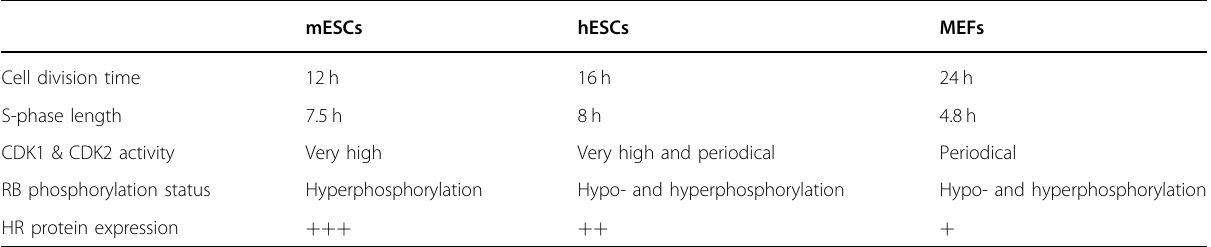
Table 1 Comparison of cell cycle features (Refs. 8,14,24,42